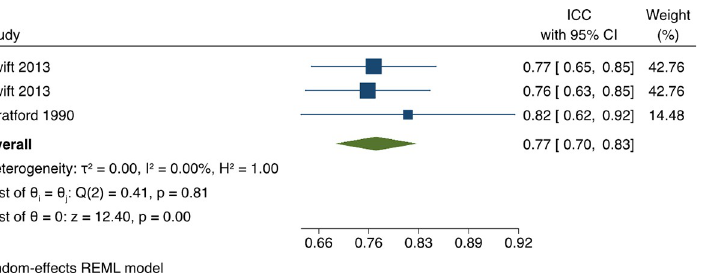
Fig 6. Meta-analysis of intraclass correlation coefficient (ICC) on OSCEs in physical therapy students. Forest plot presenting the meta-analyzed estimate on ICC. Each square presents the results of an individual study with the size of the square being proportional to the weights used in the meta-analysis and the horizontal lines indicating the 95% confidence intervals. The solid diamond indicates the overall summary measure.